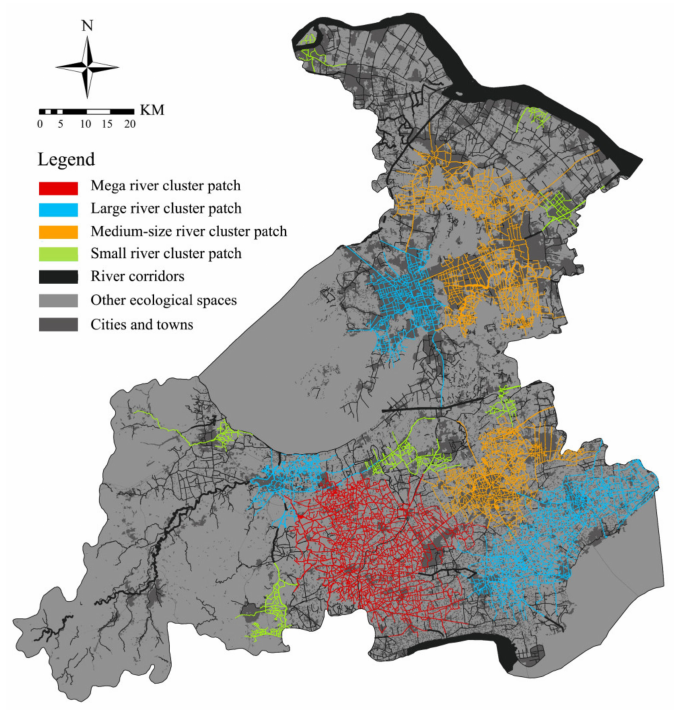
Figure 3. Extraction and multi-level division of river cluster patches in the Hu-Su-Jia area.